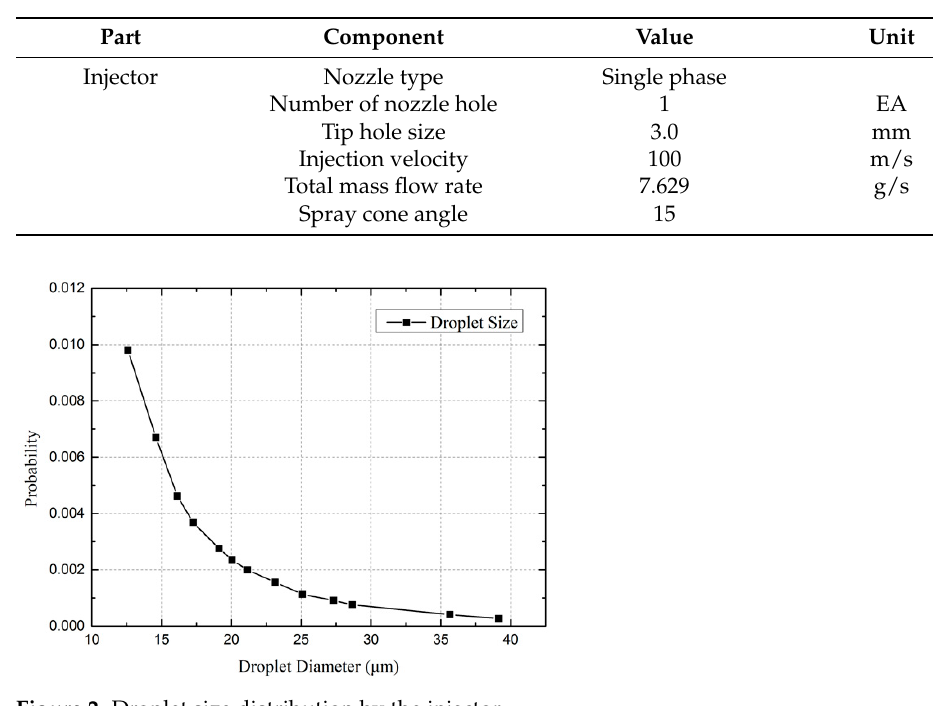
Figure 2. Droplet size distribution by the injector.